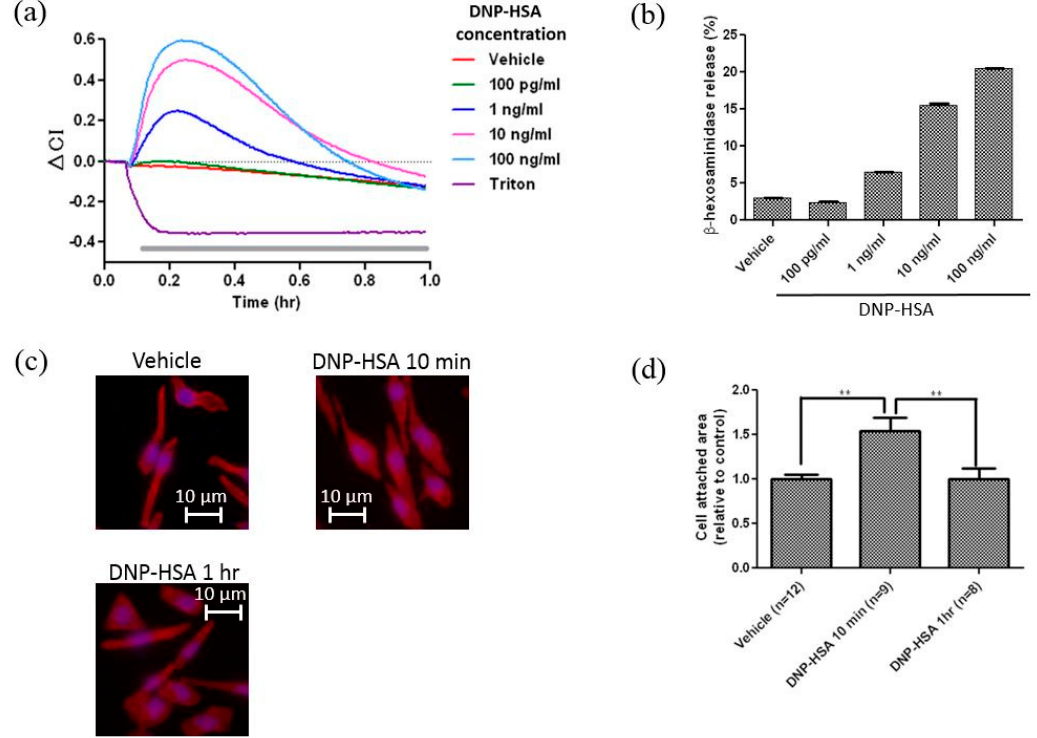
Figure 2. ( a ) CI changes ( ∆ CI) of RBL-2H3 cells in response to various concentrations of antigen. The gray bar indicates the presence of DNP-HSA or Triton. CI first increased in a DNP-HSA concentration-dependent manner. Maximum CI changes were observed around 10 min after the stimulation. CI, then, decreased to baseline in around 1 h. ( b ) Degranulation of RBL-2H3 cells in response to various concentrations of antigen. Degranulation of RBL-2H3 cells was evaluated with release of β -hexosaminidase, a granule marker, by measuring the hydrolysis of p-nitropheny-N-acetyl- β - glucosamine to the chromatophore, p-nitrophenol. The graph is representative of three experiments. Data were obtained from quadruplicate measurements. ( c ) Changes of the adhesion area of RBL-2H3 cells in response to DNP-HSA. Red shows actin cytoskeleton stained by phalloidin-TRITC, and blue shows nuclei stained by DAPI. White bar shows ca. 10 µ m. ( d ) The relative cell area of RBL-2H3 cells before and after stimulation by DNP-HSA. The adhesion area of each cell was measured by using Image-Pro Plus 6.3J (Media Cybernetics, Bethesda, MD, USA). The difference between the area of cells among each group was statistically analyzed using a one-way analysis of variance followed by Tukey’s test (** p < 0.01). ‘n’ means the number of cells measured.